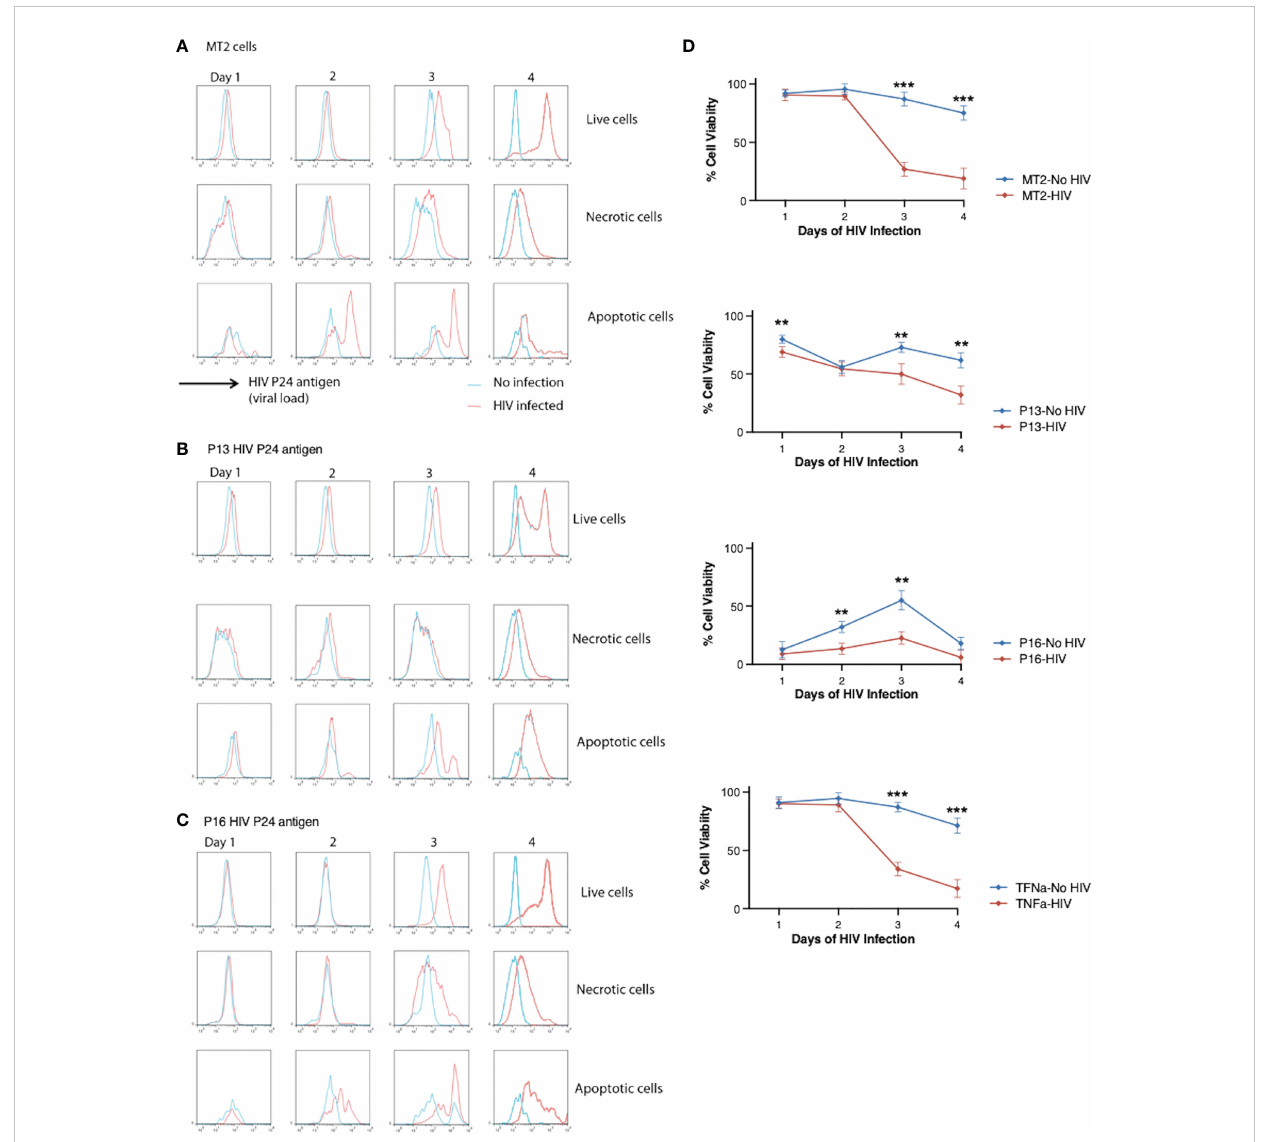
FIGURE 4 Effect of P13 and P16 on viral load and cell death in MT2 cells infected with HIV. (A) MT2 cells were infected at day 0 with HIV IIIB (MOI 0.001). Caspase-3 and live-dead dye staining were used to identify live (Caspase-3 − live-dead dye-), necrotic (Caspase-3 − live-dead dye+), and apoptotic (Caspase-3+ live/dead dye − ) cells. HIV p24 stained with PE-conjugated anti-p24 antibody was used as a measure of viral load and measured by fl ow cytometry over 4 days. (B) MT2 cells were infected as before in presence of P13 peptide (100 m M). (C) MT2 cells were infected as before in presence of P16 peptide (100 m M). (D) Cell viability was measured in HIV-infected or non-infected MT2 cells in presence or absence of P13, P16 peptide (100 m M) or whole TNF protein (20 ng/ml). Red lines indicate p24 levels (A-C) or cell viability (D) in HIV-infected cells and blue lines indicate those in non-infected cells. Data are from four independent experiments. **p < 0.01, ***p < 0.001 (Multiple unpaired